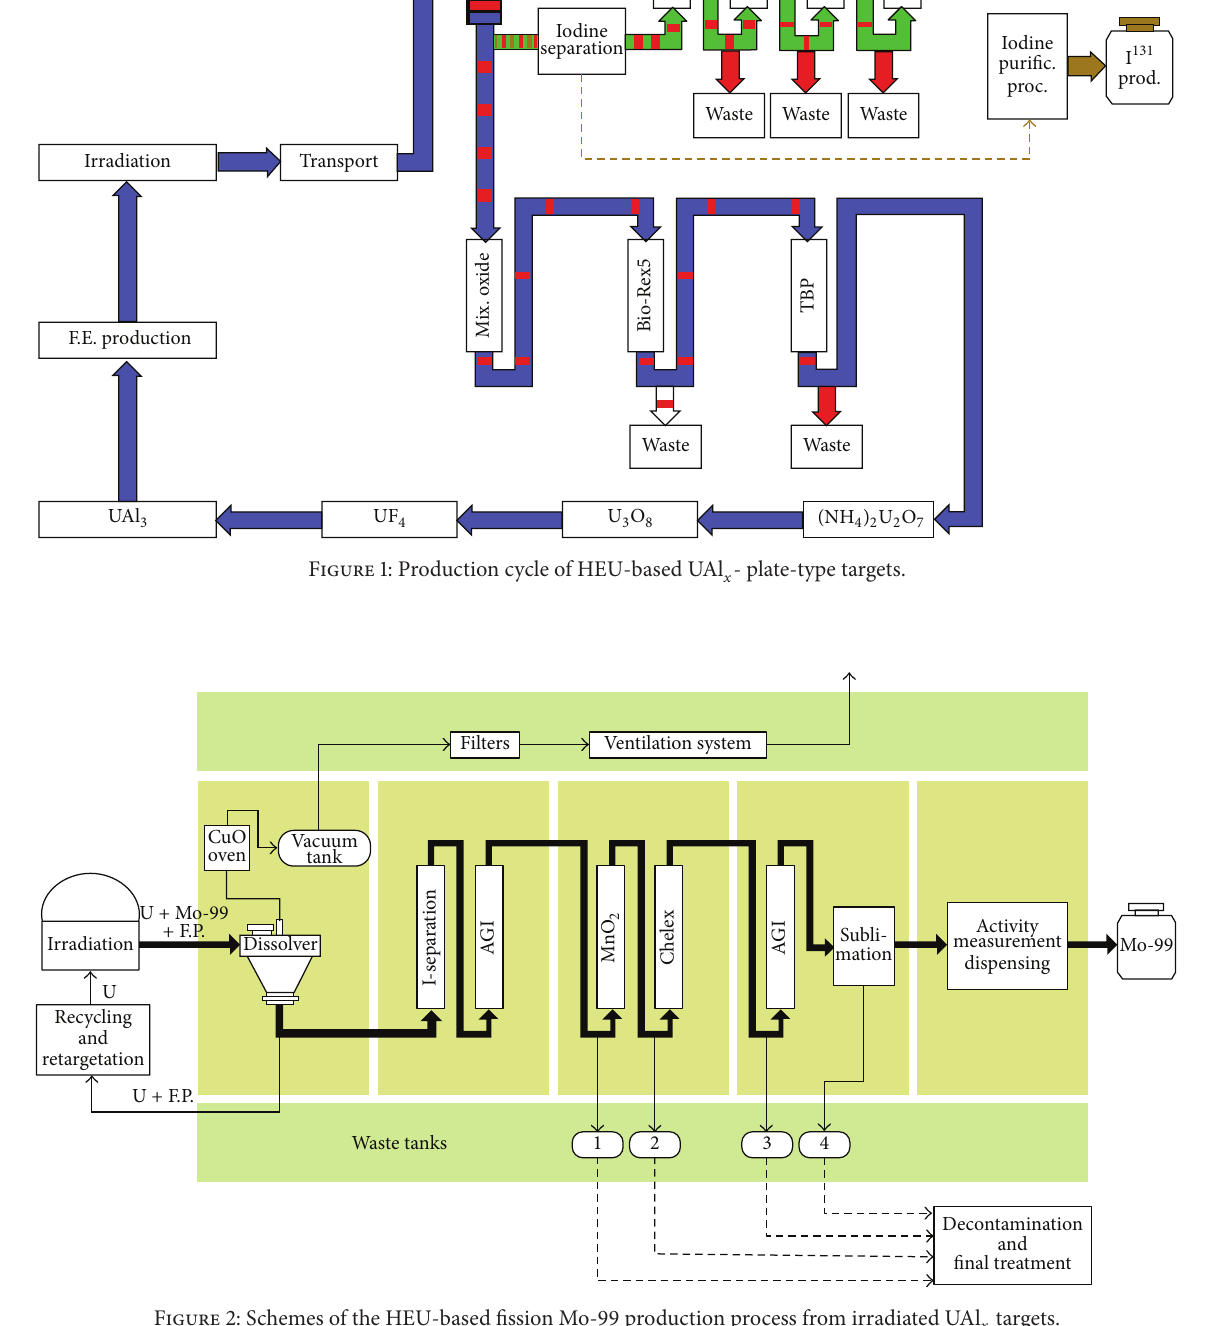
Figure 2: Schemes of the HEU-based fission Mo-99 production process from irradiated UAl 𝑥